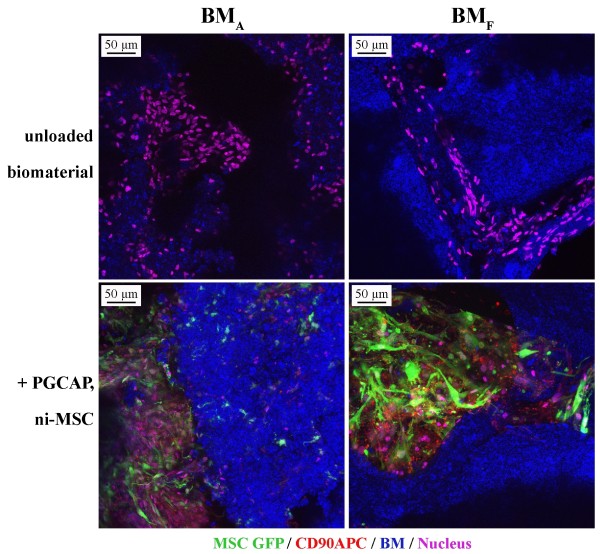
Ex vivo confocal microscopy analysis of BMA and BMF biomaterials. Not induced- mesenchymal stromal cells (ni-MSCs) or osteogenic induced-MSCs (i-MSCs) GFP+ loaded on BMA and BMF at high cell seeding density (200 × 103 cells per biomaterial) were embedded or not in PGCAP and grown for 21 days. Next, biomaterials were subcutaneously grafted on nude mice. Unloaded biomaterials (no pre-loaded cells and not embedded in PGCAP) were also grafted on mice. Twenty-eight days after grafting, biomaterials were cut in four pieces, fixed, and stained with CD90 antibody. Biomaterials were analyzed by confocal microscopy (blue: biomaterial; green: MSC GFP+; red: CD90APC; and purple: DAPI). Original magnification: ×20. Each picture is representative of three independent experiments. DAPI, 4'-6-diamidino-2-phenylindole; PGCAP, platelet glue obtained from cryoprecipitation of apheresis platelet products.